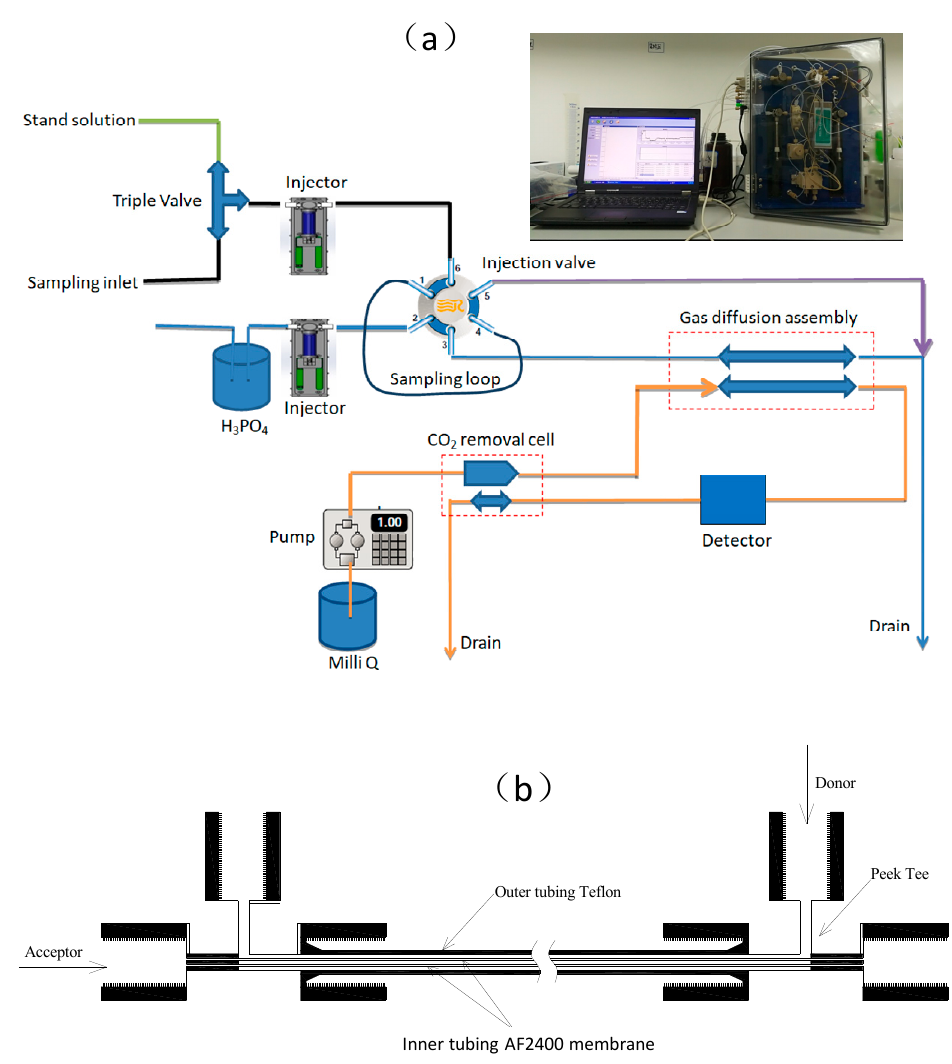
Figure 1. The schematic image of the DIC instrument, ( a ) DIC measurement system and image of DIC instrument, ( b ) Scheme of gas-diffusion assembly.